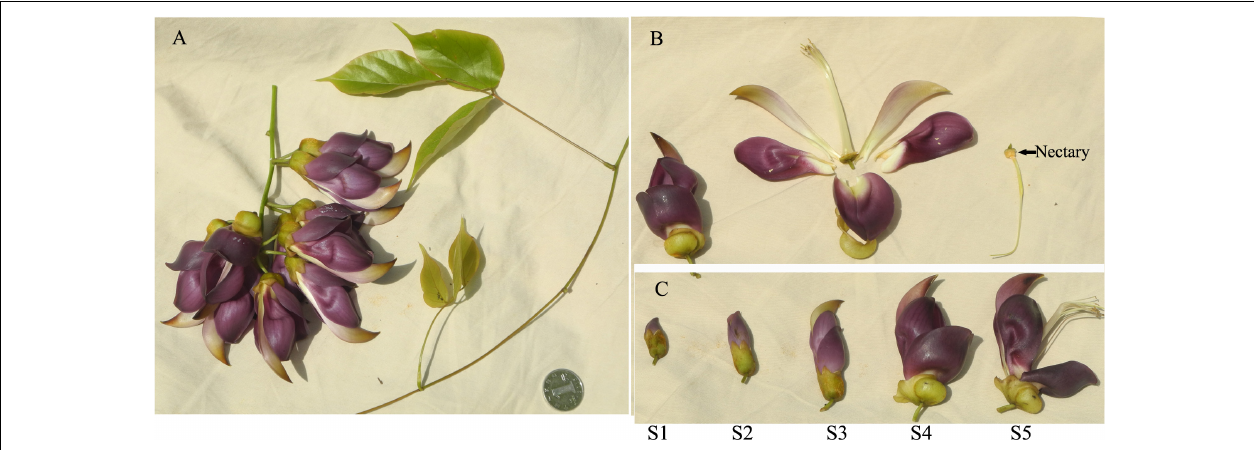
FIGURE 1 | Mucuna sempervirens plant. (A) Inflorescence, stems and leaves. (B) The structure of flower, with nectary indicated by an arrow. (C) Different developmental stages of flower. S1 stage, very young flower (corolla less than 1.5 cm long); S2 stage, young flower (corolla ca 2.5 cm long, almost half the length of the adult flower); S3 stage, near adult flower with more than 3 cm long corolla but without enlarged calyx and nectar production; S4 stage, adult flower with nectar in enlarged calyx and keel; S5 stage, old flower with keel opened, and pistil and stamen no longer contained within the